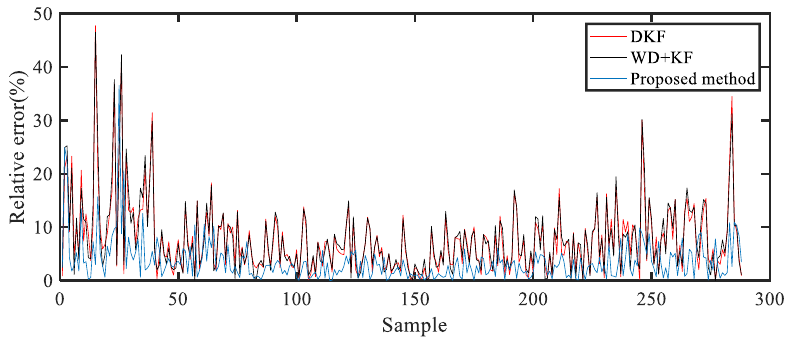
Figure 18. Two days ahead prediction errors based on the different methods.